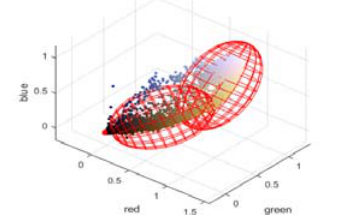
Fig. 16. Sample RGB values and estimated GMMs.